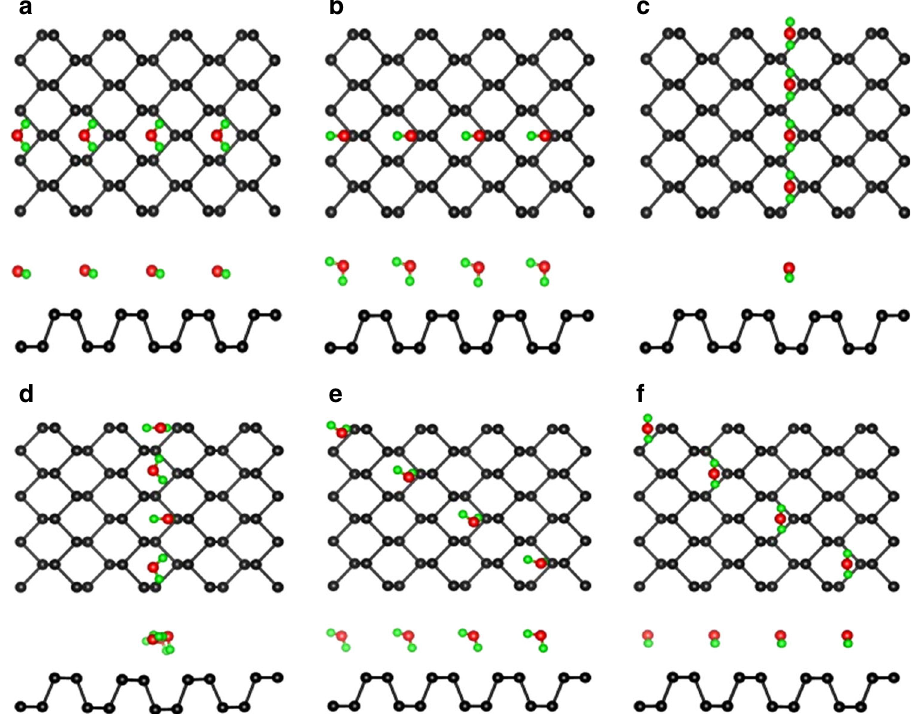
Fig. 4 Six representative high-symmetry con fi gurations for H 2 O molecules on phosphorene. a , b Along armchair direction, c , d along zigzag direction, and e , f along diagonal direction, and the total energy difference is a 0.104 eV molecule − 1 , b 0.098 eV molecule − 1 , c 0.275 eV molecule − 1 , d 0 eV molecule − 1 , e 0.123 eV molecule − 1 , and f 0.150 eV molecule − 1 ,